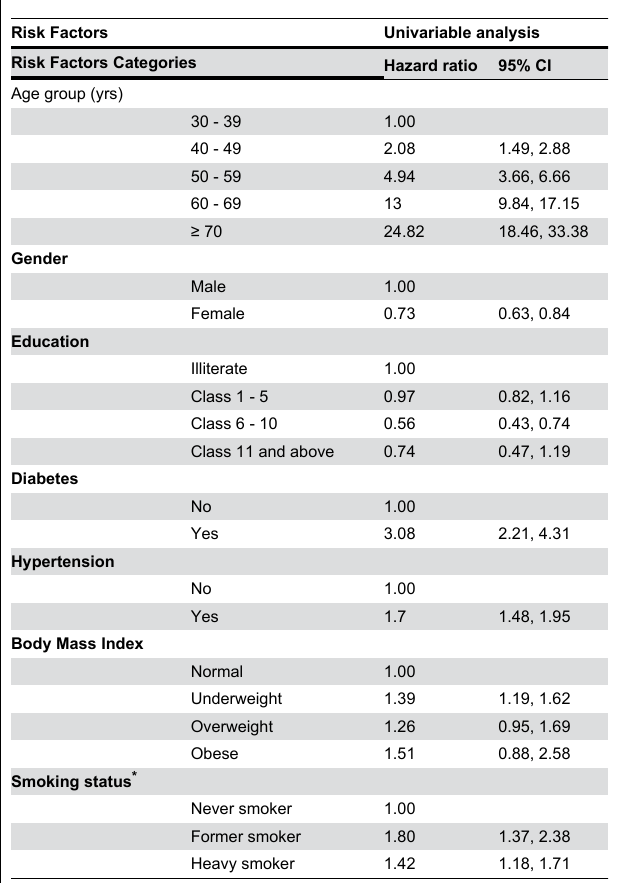
Life table graphs showing the probability of death by follow up time (unadjusted and adjusted for age and gender) and presence of VI and morphology of cataract at baseline are shown in figures 2 and 3. Participants with VI or blindness (uncontrolled and after controlling for age and gender) were at increase risk of mortality ( P <0.001;Figure 2). Similarly, those with pure nuclear, cortical and PSC were also at increase risk